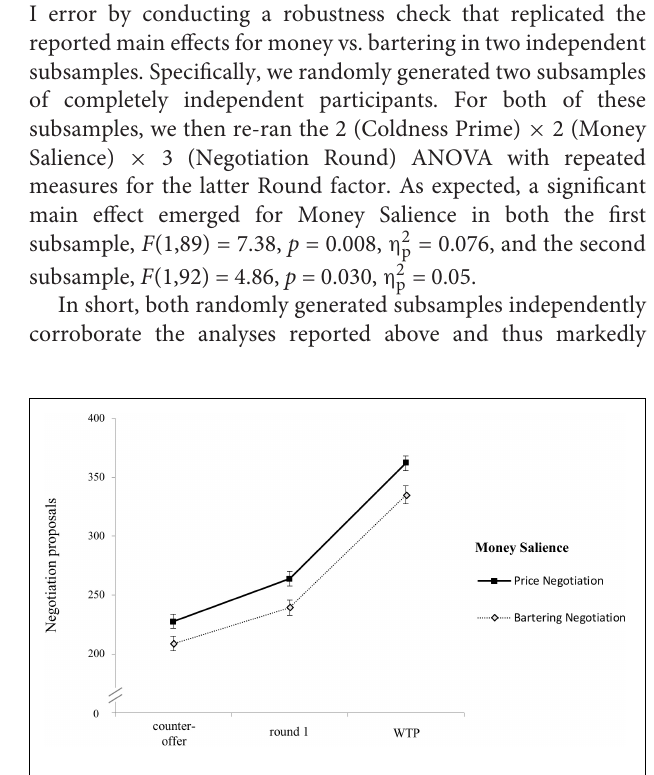
circles) were anchored less by the opponents’ first offer than participants in the price negotiation (black squares). This initial difference for counteroffers was maintained over the course of negotiations and culminated in a lower willingness to pay (WTP) for the bartering compared to the money condition. Error bars represent +/– 1 SEM